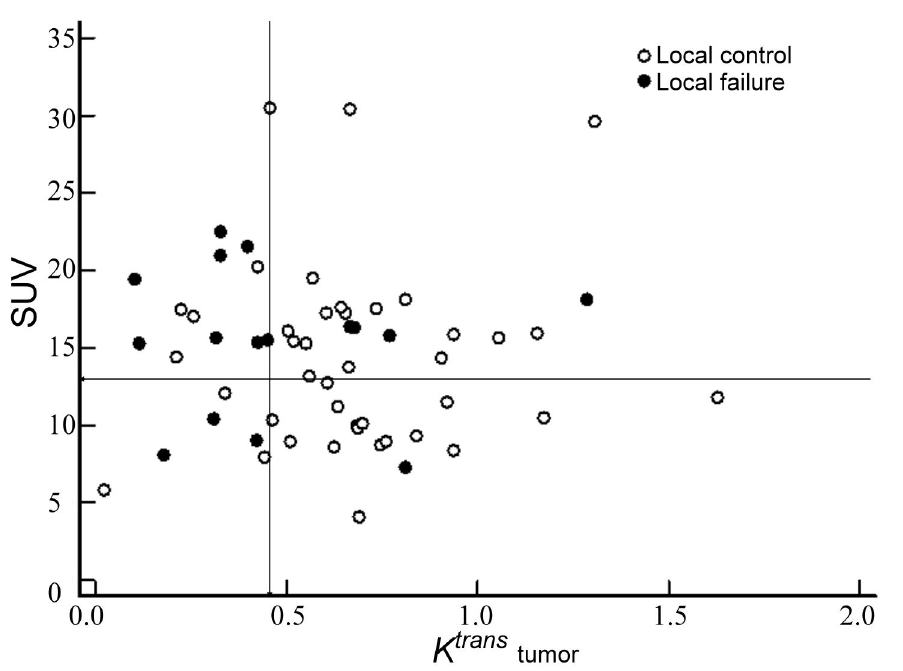
. The entire max . max